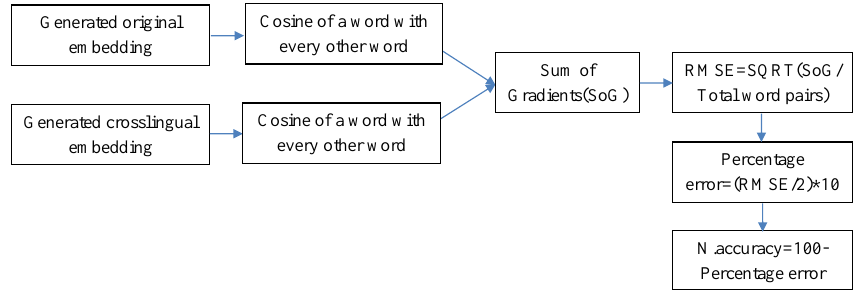
Figure 5. Pipeline for computing cosine neighborhood